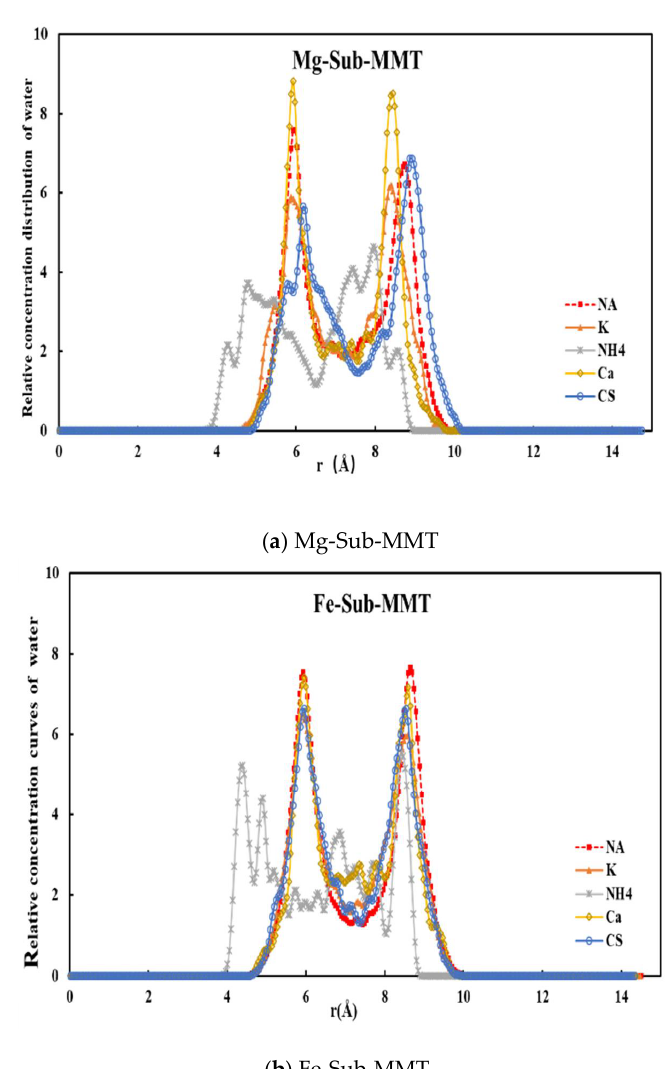
Figure 3. Z-axis relative concentration curves of water.